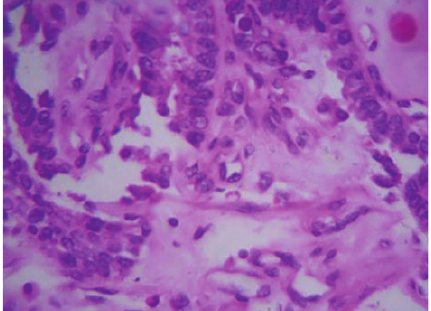
Figure 1: Clinical photograph of the right breast showing the mass.